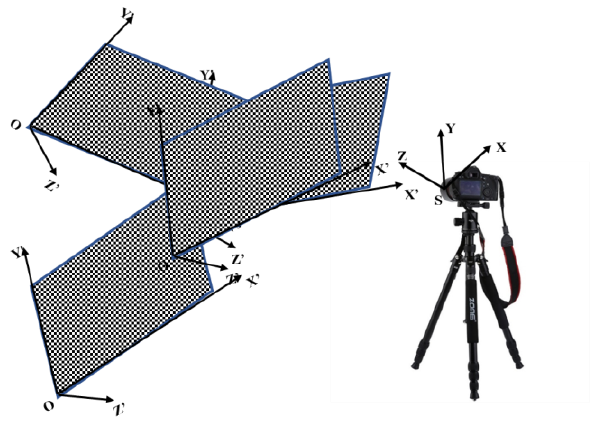
Figure 1. Imaging principle for calibrating the camera (the camera is stationary, but the chessboard moves and tilts) Then all images are processed together, considering them as one image with fixed exterior orientation elements. In other words, exterior orientation elements of images are not defined, but